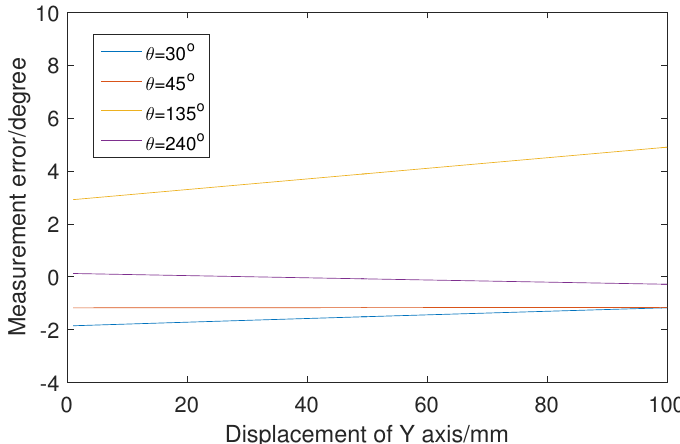
Figure 12. Measurement error in the simulation experiment when vectors move along the line y =